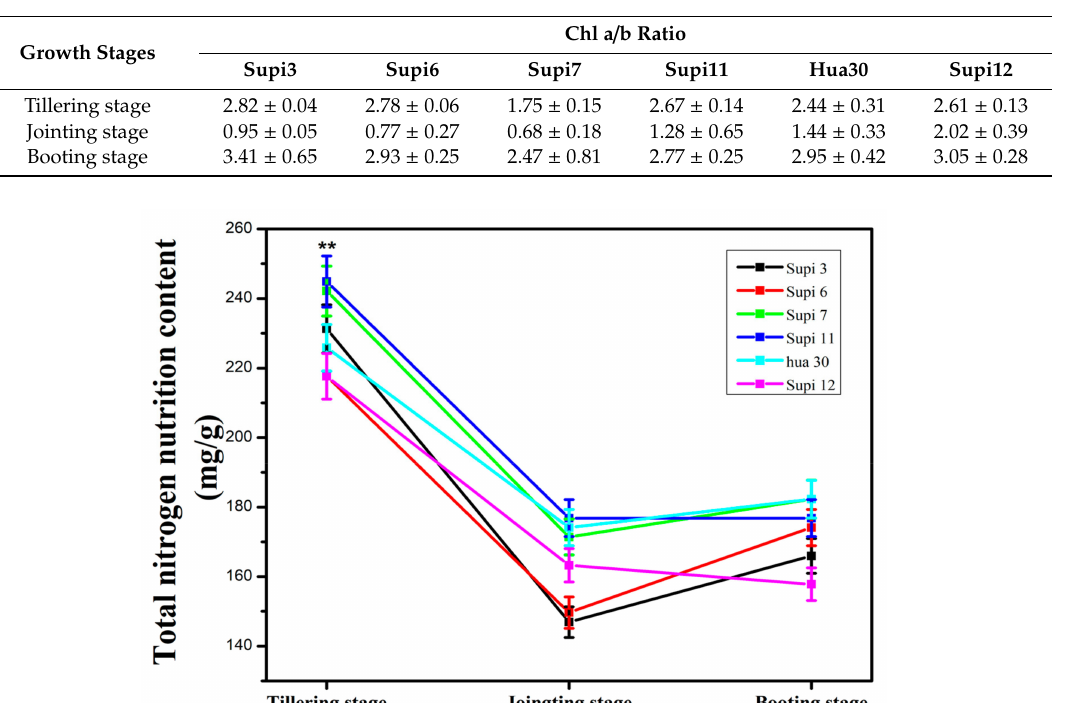
Chlorophyll a / b (Chl a / b ) ratio (mean ± SD) in the six barley cultivars at di ff erent developmental stages.